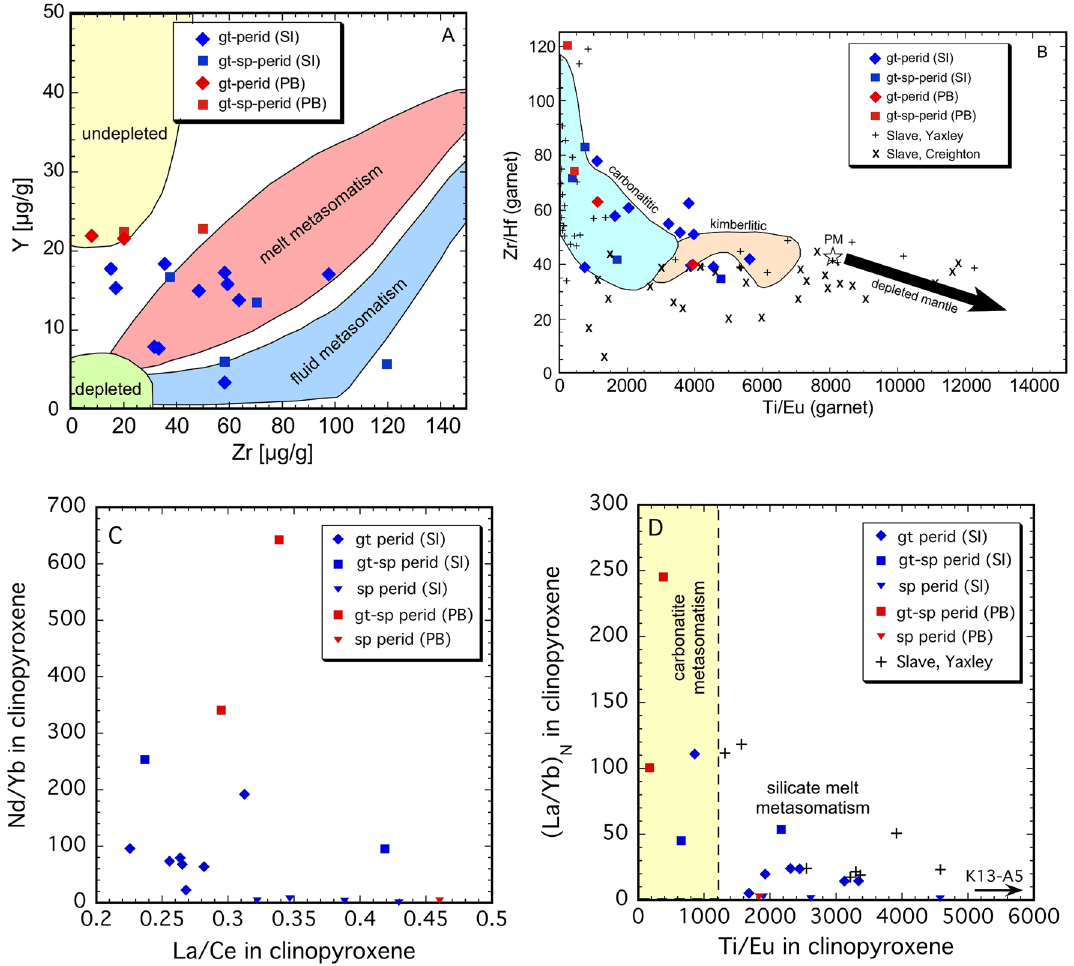
Figure 3. Selected trace element variations in garnet ( A , B ) and clinopyroxene ( C , D ) that can be used as indicators of metasomatic processes. Fields in ( A , B ) after Griffin et al. 32 and Shu and Brey 33 , respectively. The demarcation of carbonatite and silicate melt metasomatism in ( D ) is from Coltorti et al. 35